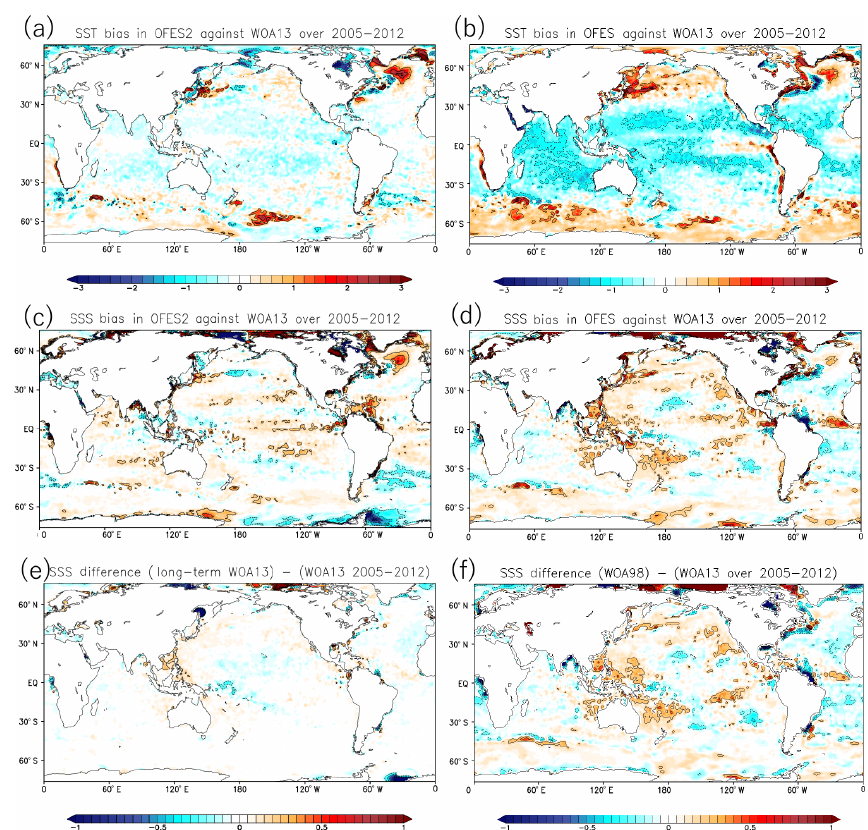
Figure 4. SST bias ( ◦ C) in (a) OFES2 and (b) OFES averaged over 2005–2012 against WOA13. Panels (c) and (d) are the same as (a) and (b) , respectively, but the SSS bias is shown instead (psu). SSS differences in (e) long-term WOA13 and (f) WOA98 from WOA13 averaged over 2005–2012. The contour lines are superimposed at an interval of 1 ◦ C for SST and 0.2psu for SSS, but zero contour lines are